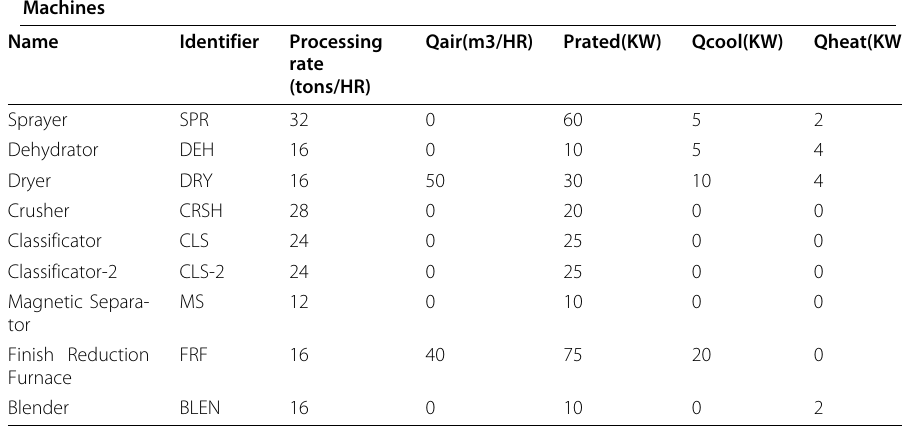
Table 7 Parameters for the modeled machines in MFS